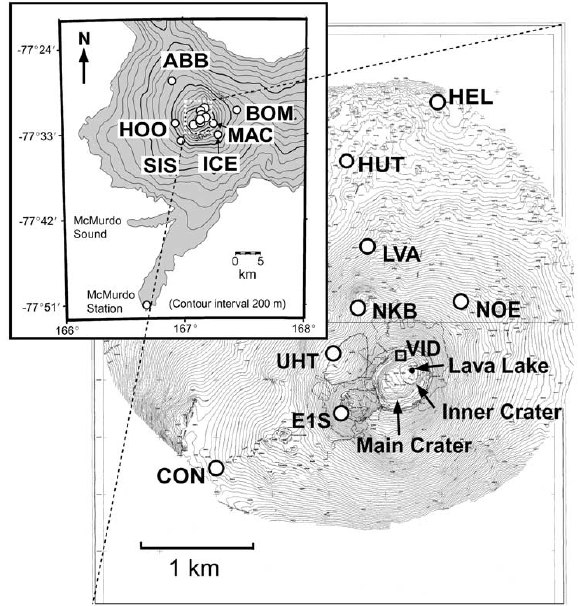
Fig. 5. Erebus, Ross Island (Antarctica): map of the volcano with the location of the permanent MEVO short-period and broadband seismic network, and the temporary PASSCAL